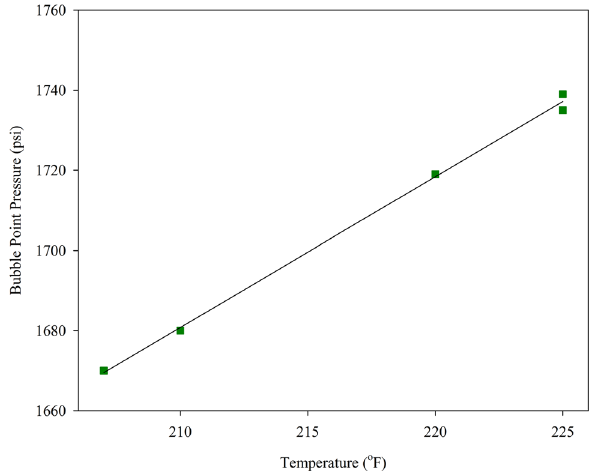
Fig. 11 Linear dependency of bubble point pressure to temperature in Fields A and C. This relation means that by dividing the bubble point pressure by the temperature, the effect of temperature is also consid- ered